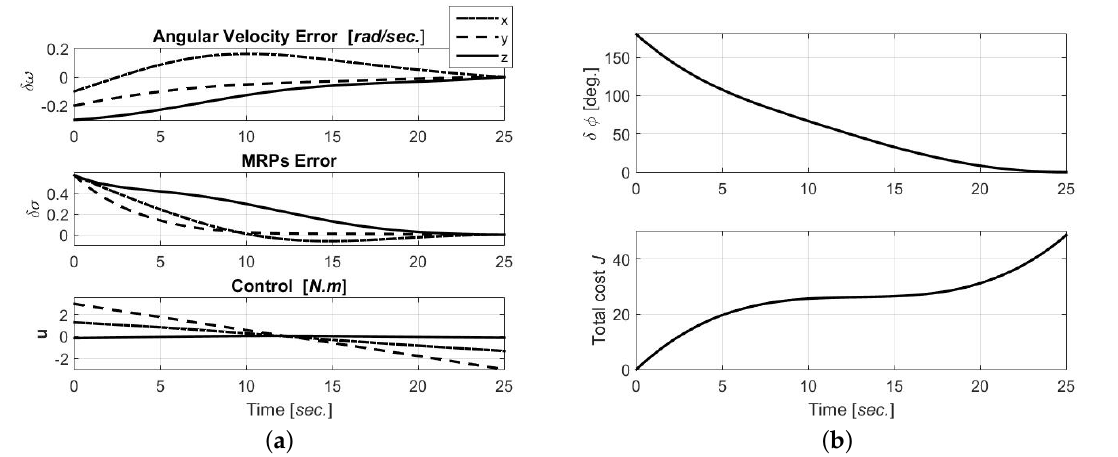
Figure 5. Open-loop optimal solution for the tracking motion. ( a ) Time history of the optimal trajectory, ω and MRPs, and control. ( b ) Time history of the principal angle and the total optimal